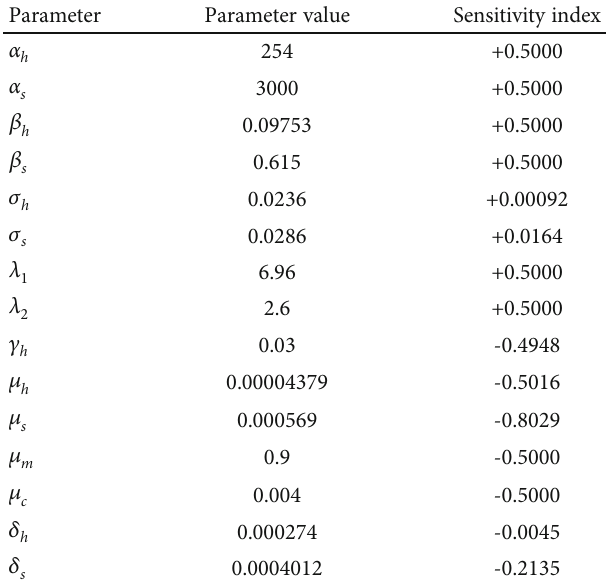
Table 2: A table showing the sensitivity index of each model parameter on R 0